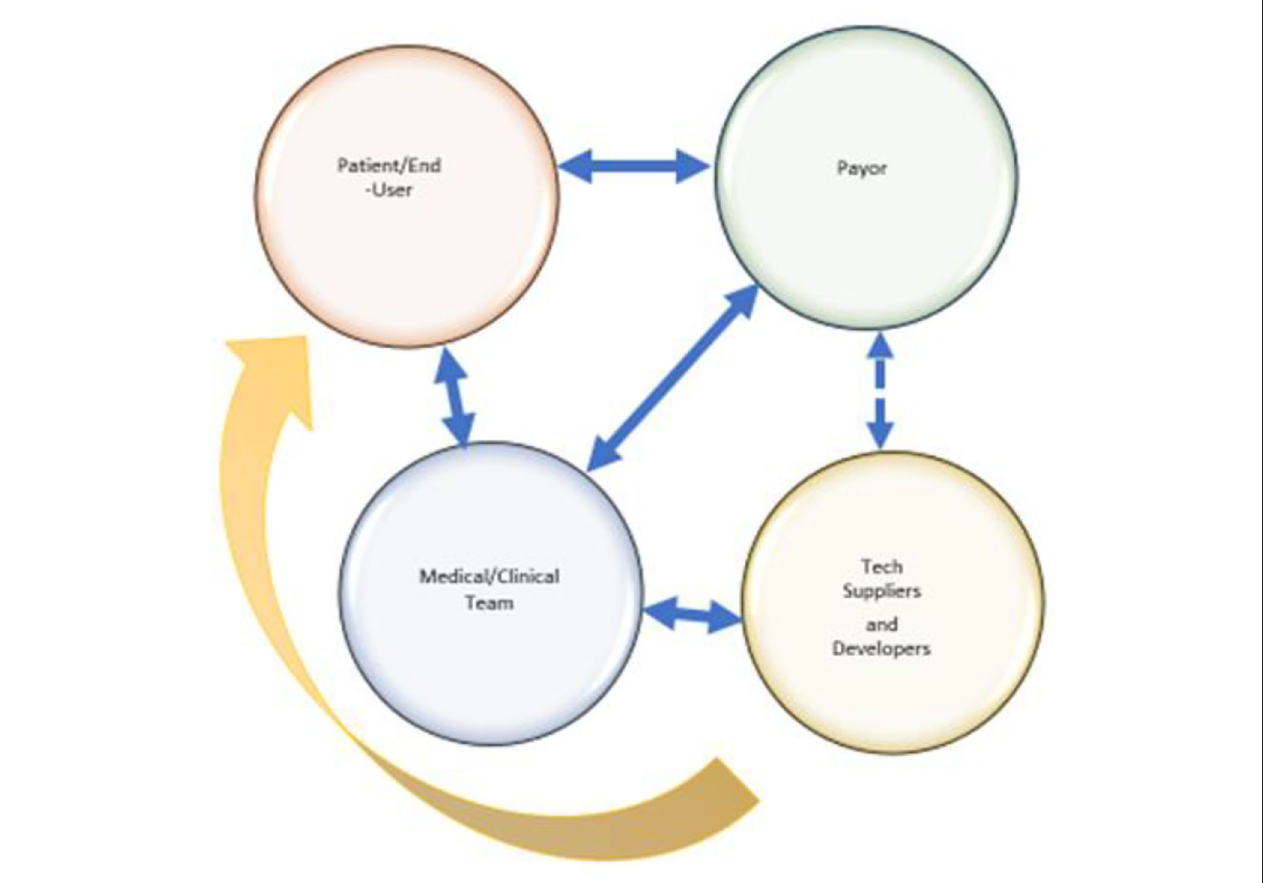
FIGURE 3 | Communication Lines: Established Traditional Communication Lines (Solid Blue), Intermittent Traditional Communication Lines (Dashed Blue), Social Media Enabled